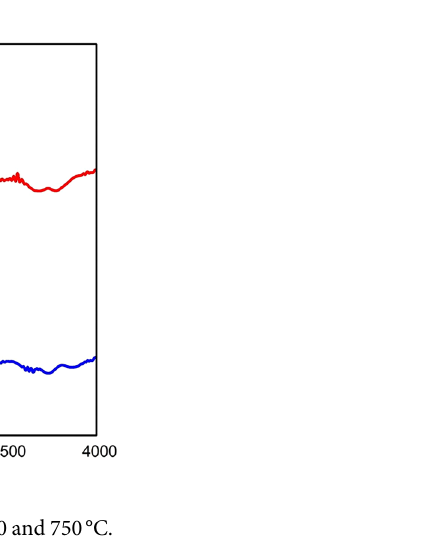
Figure 6. Raman spectra of PAC/Ni and CNM produced at 650 and 750 °C.